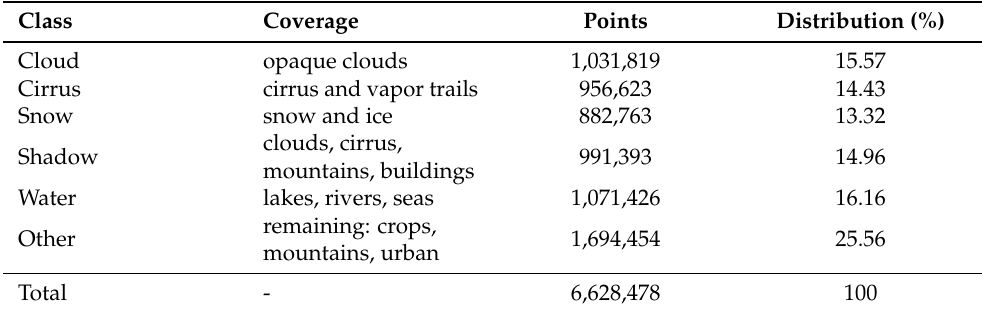
Table 2. Holstein et al. [40] Dataset: Description of Classes with Coverage and Distribution of